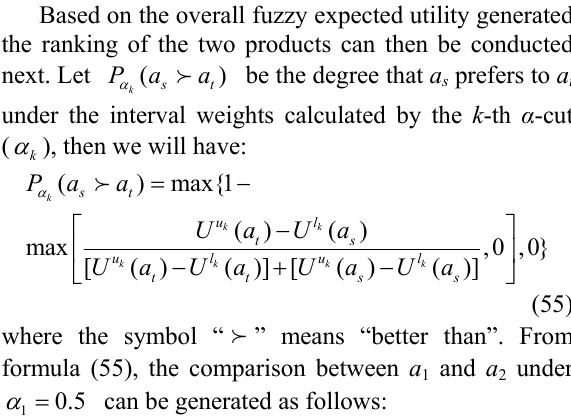
Fig. 14. Overall fuzzy utilities of the 2 products under